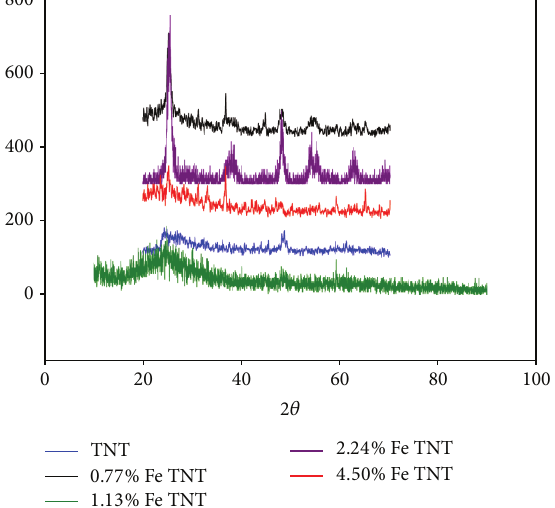
Figure 2: XRD spectra of the different Fe-doping catalyst.